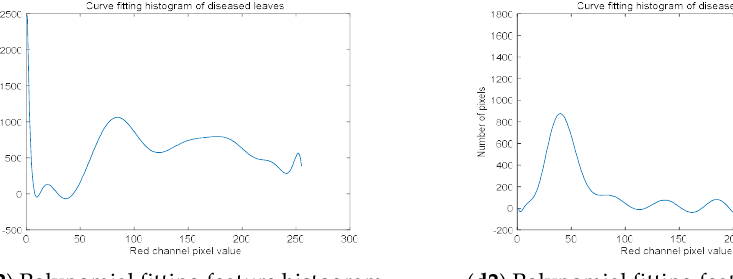
Figure 4. Feature histograms of diseased leaves.